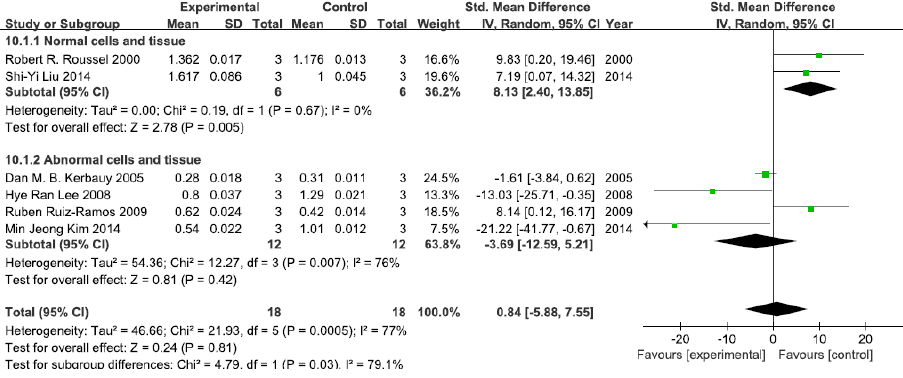
Figure 2. Effects of arsenic on phosphorylase inhibitor of kappa B (p ‐ I κ B). Forest plot showing the impact of arsenic treatment on p ‐ I κ B compared with controls. Abbreviations: SMD = standardized mean difference, IV = independent variable, 95% CI = 95% confidence interval.